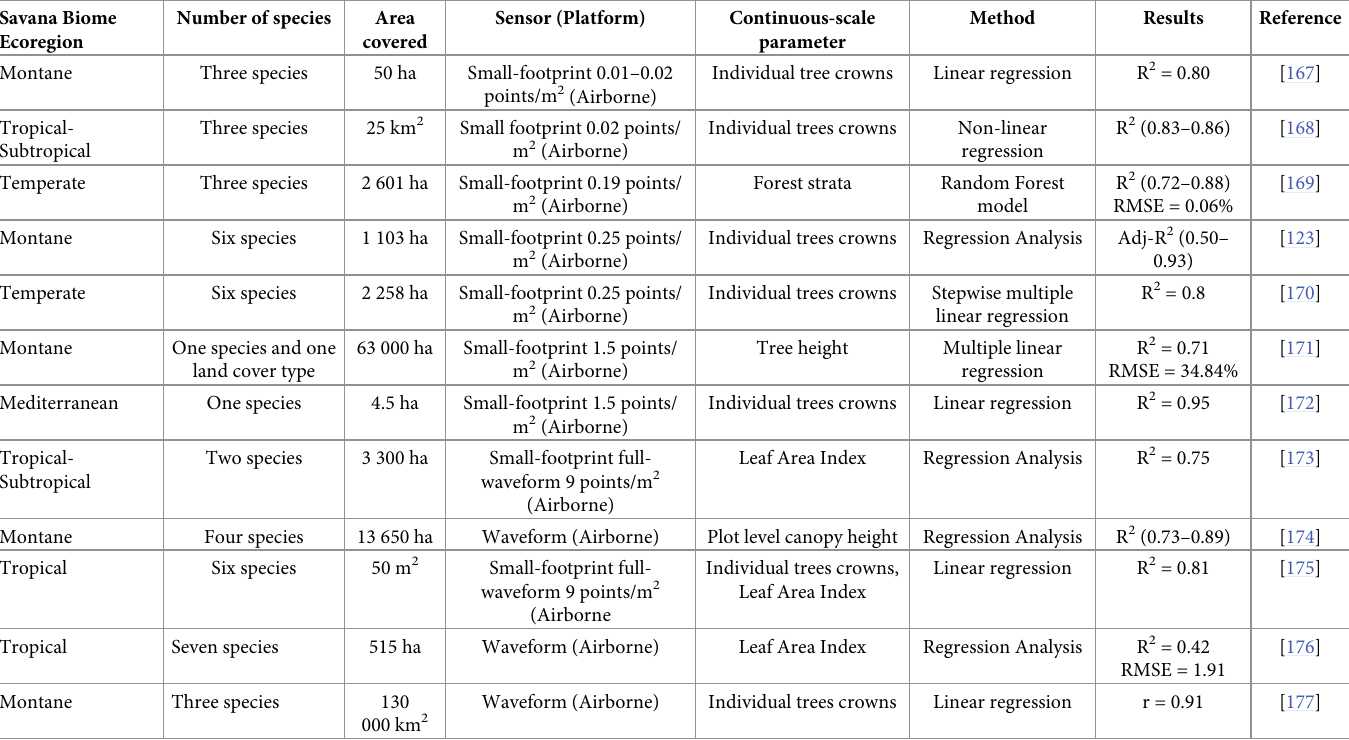
Table 6. Examples of studies that estimated savanna woody plant species diversity using continuous-scale and LiDAR remote